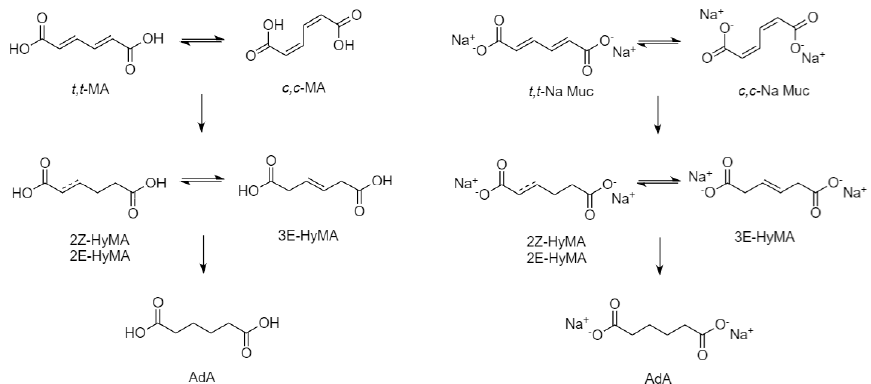
Figure 1. AdA production over the time for each of the catalysts. Reaction conditions: MA concen- tration 0.1 M, temperature 70 °C, 2 bar pressure of H 2 , metal/substrate ratio 1/500.